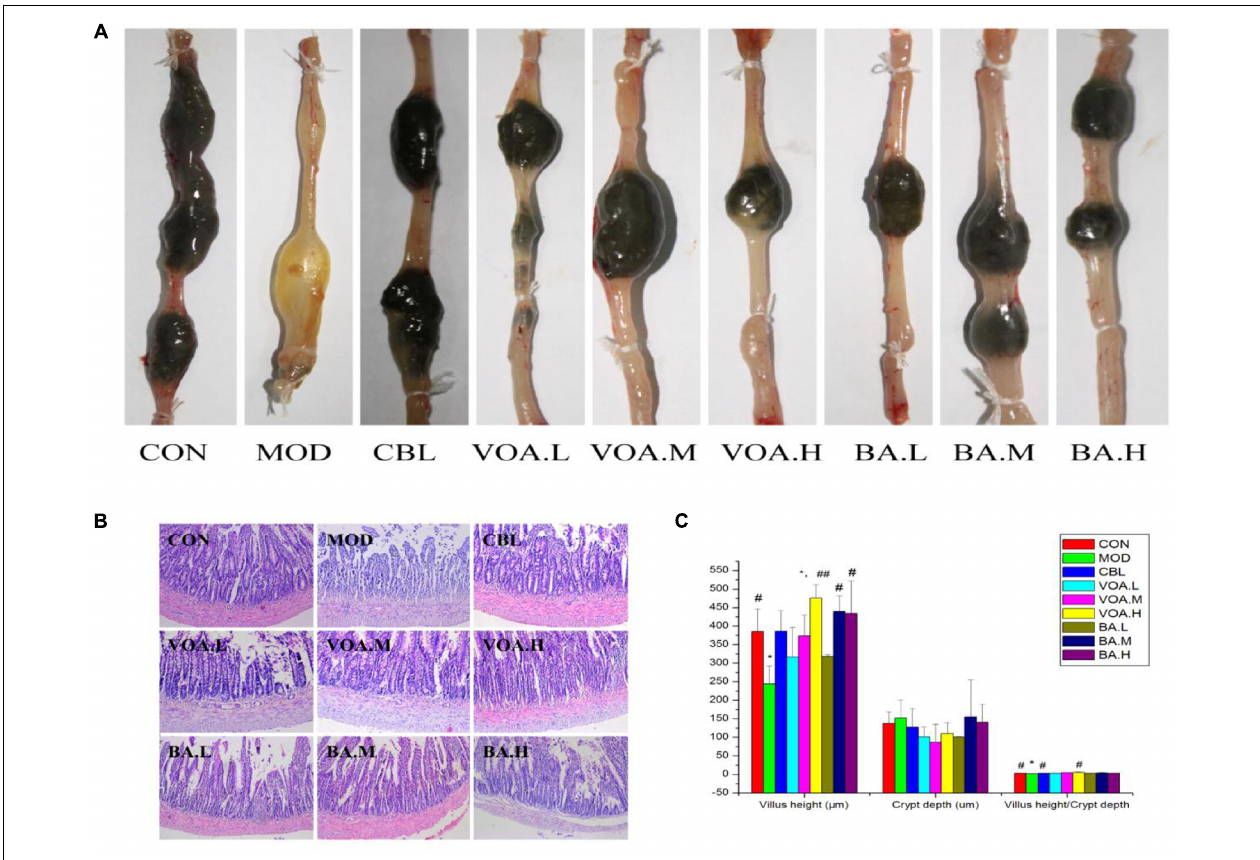
FIGURE 4 | (A) VOA and BA reduced diarrhea after 5-FU induced intestinal mucositis. Stool from the 5-FU group and other treatment groups. (B) Reduced intestinal damage after VOA and BA treatment. Photomicrographs (10 × ) of the jejunums from the control, model, and treatment groups ( n = 3). 5-FU shortened villi, deepened crypts, and increased inflammatory cell infiltration. VOA and BA reduced this side effect. (C) Reversion of 5-FU-induced intestinal morphometric changes by VOA and BA in rats, n = 3. Segments of jejunum retrieved to measure villus height, crypt depth and the villus:crypt ratios. ∗ Significant difference compared to the controls. Values are means ± SD. # Significant difference compared to the model and controls. ∗ p < 0.05, # p < 0.05, and ## p <